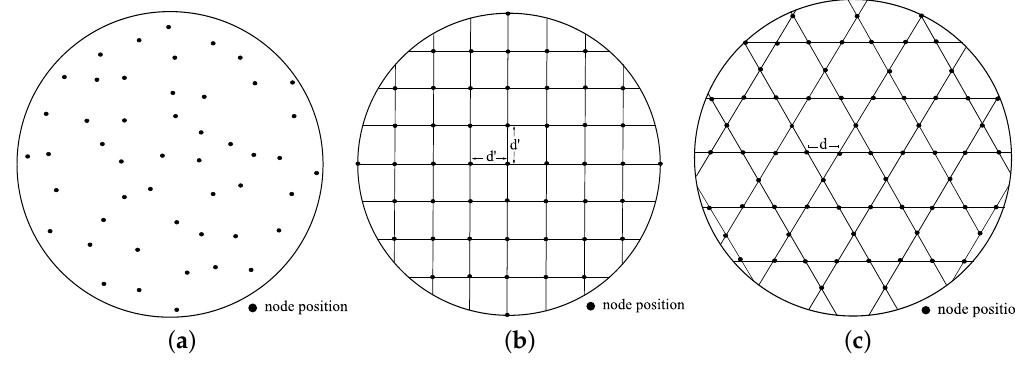
Figure 13. ( a ) Random, ( b ) square grid and ( c ) tri-hexagon tiling (THT) node